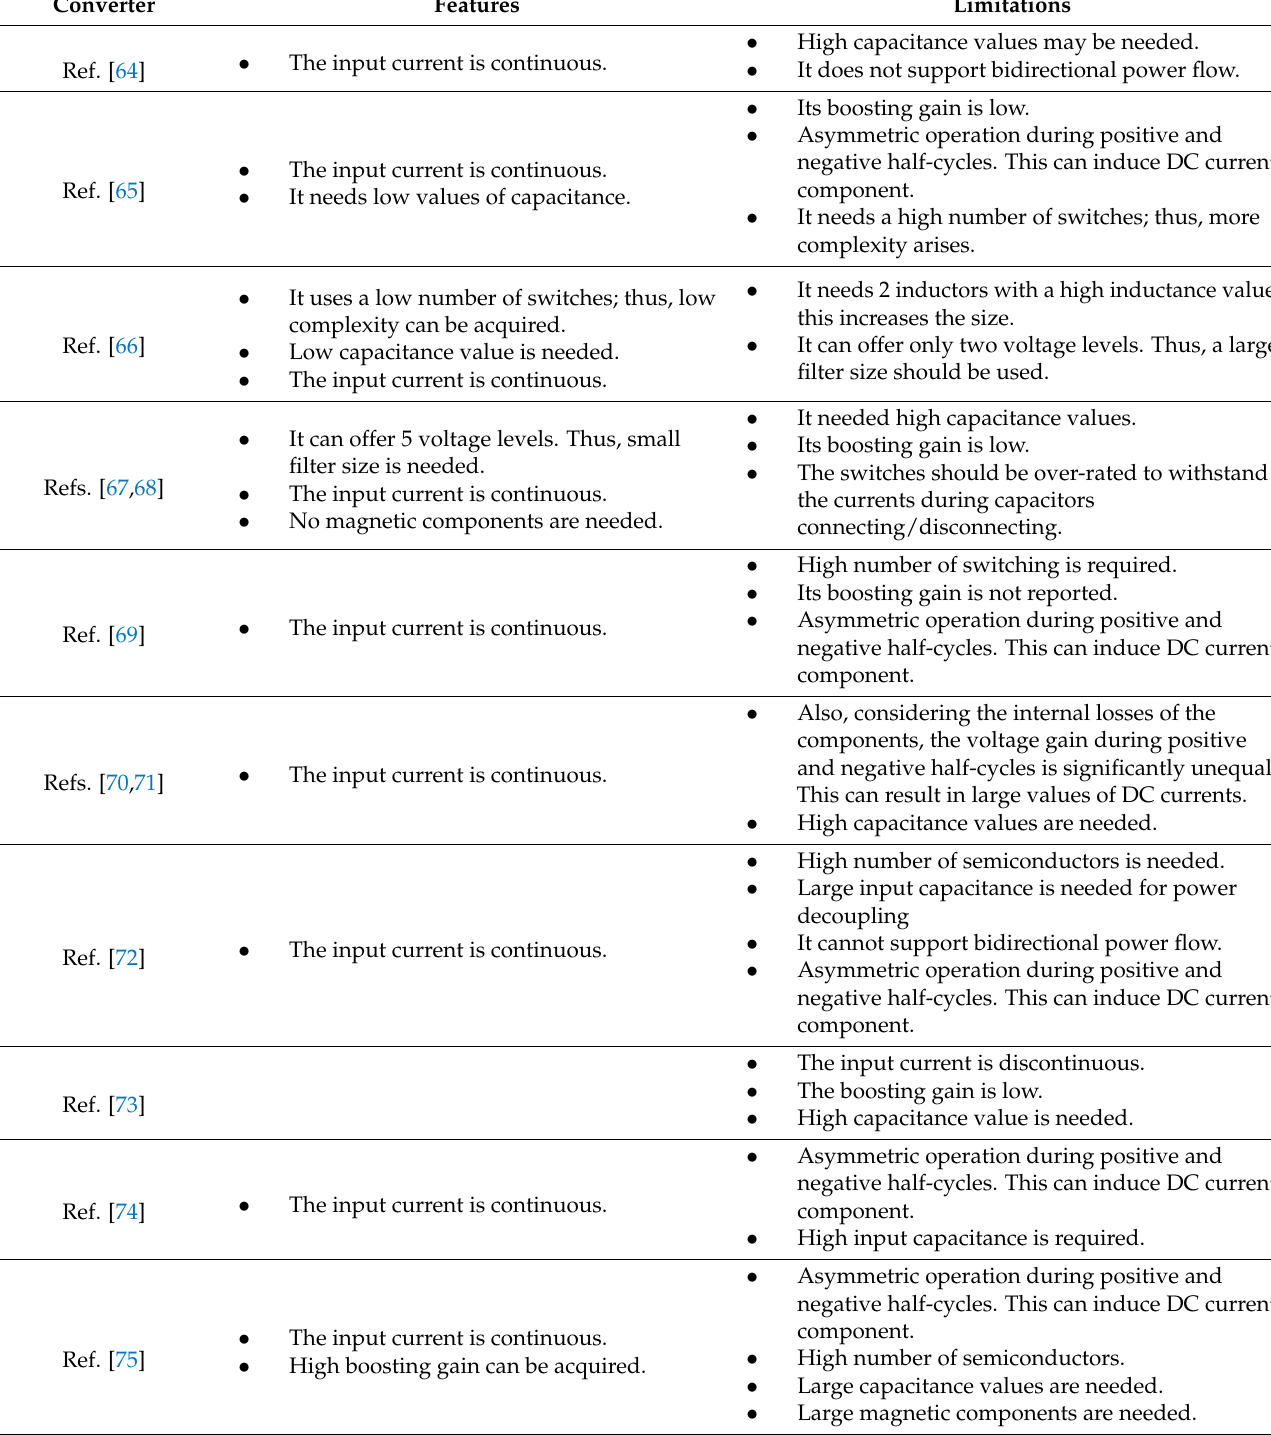
Table 7. Features and limitations of voltage-source CG converters (buck/boost